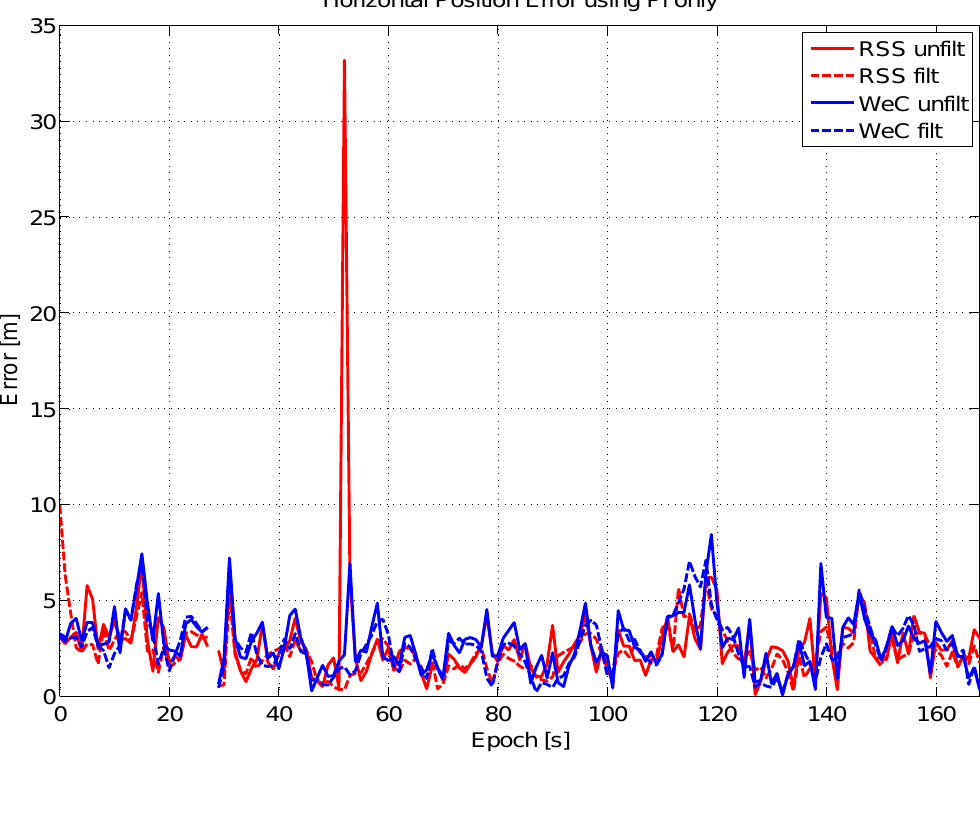
Figure 17. Horizontal error as a function of time, pseudolite-only